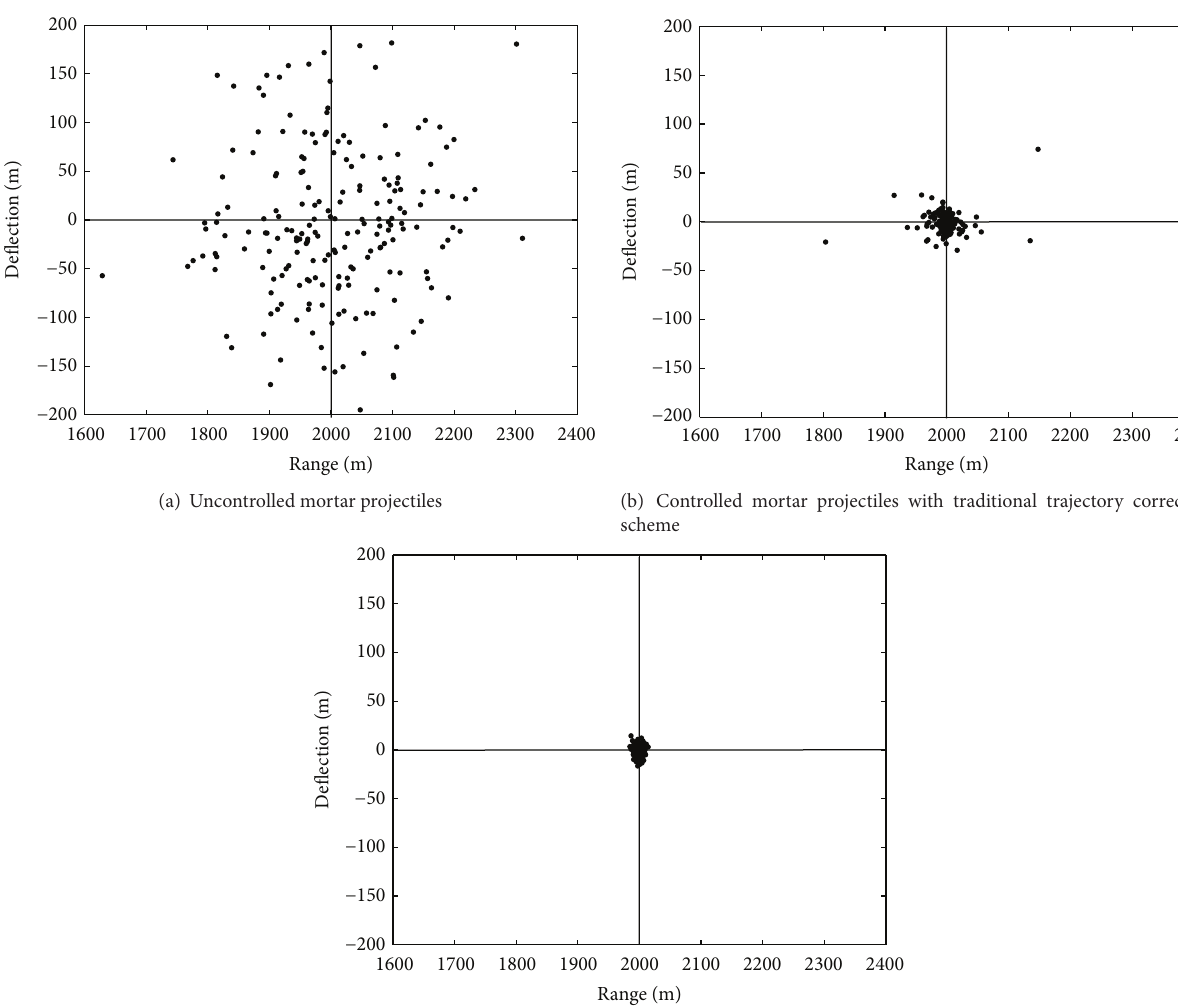
Figure 19: Impact point distribution.